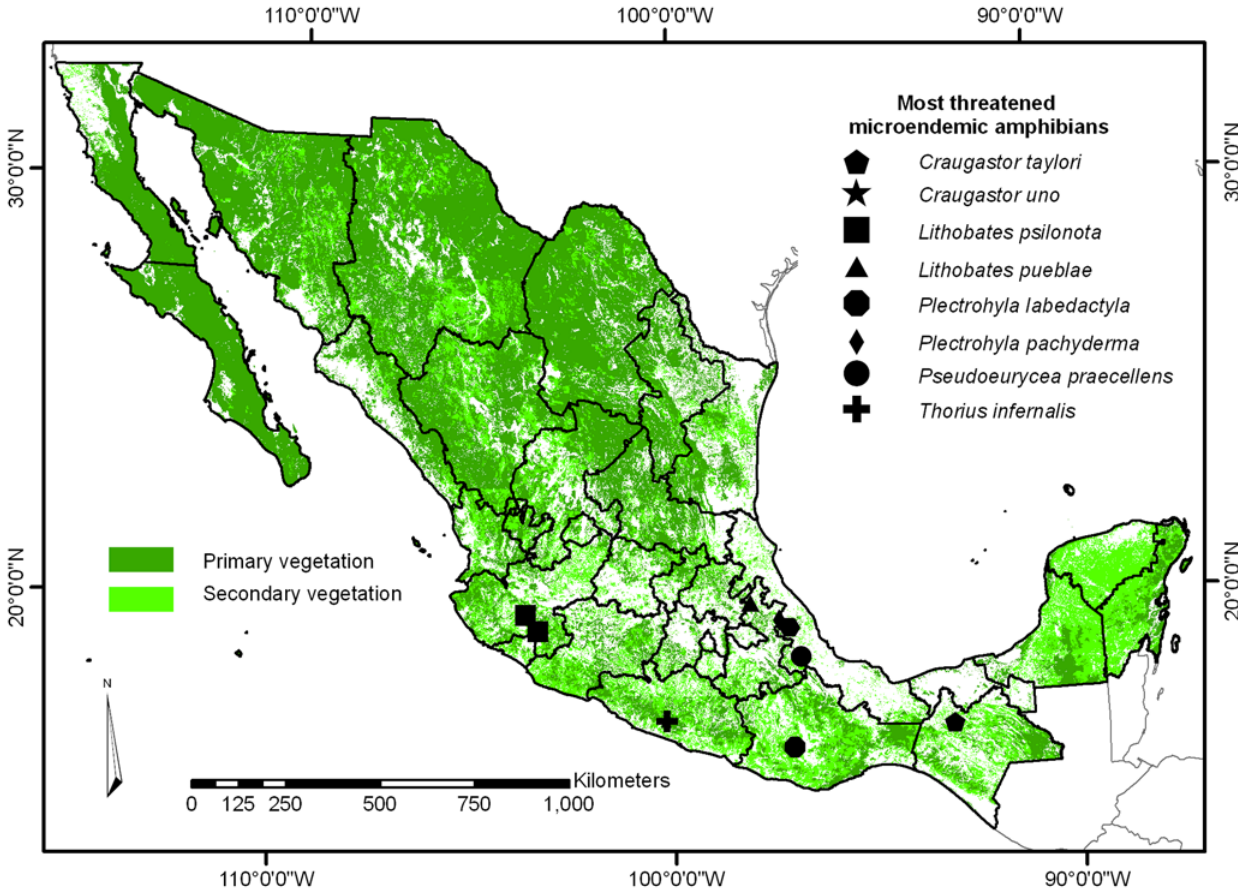
Figure 2. Location of the most threatened micro-endemic amphibians in Mexico. Black figures represent the database registers; transformed areas (TA) represented in white; dark-green polygons representing primary and light-green secondary vegetation. Craugastor uno and Thorius infernalis registers are very close, and the symbols in the map are overlapped, zoom of each species location are available in supporting information (Figs. S1–S9).